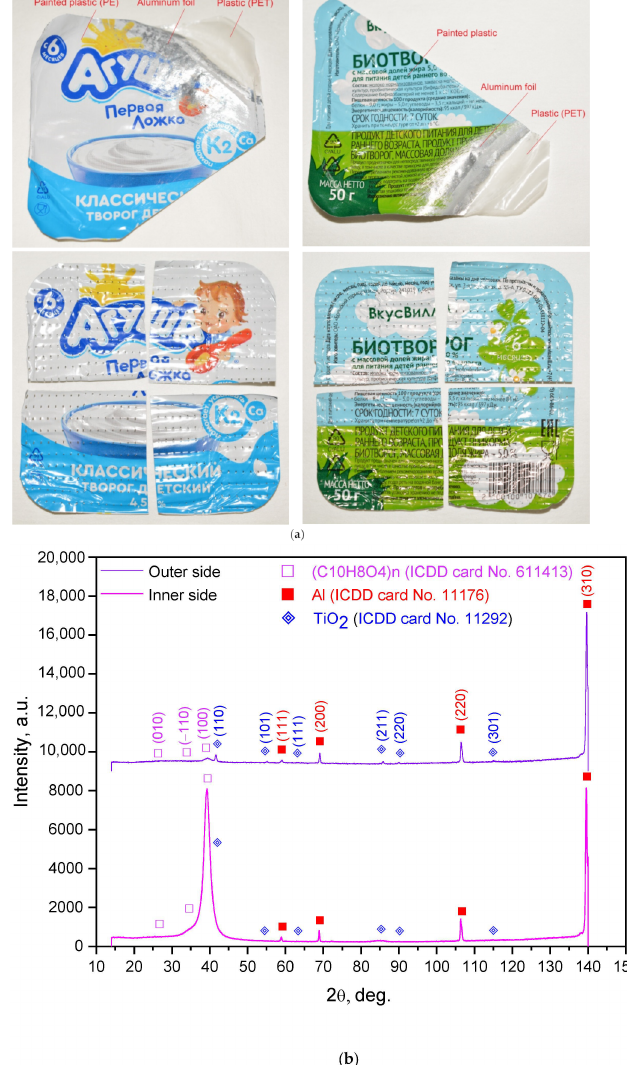
Figure 7. Characterization of plastic–aluminum–plastic samples: ( a ) general view (original and with partially separated layers); ( b ) XRD patterns of the sample recorded from the inner (plastic) and outer (painted plastic)